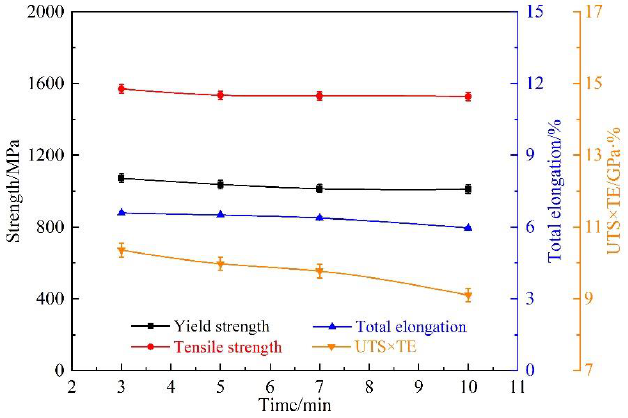
Figure 15. The strength, elongation and UTS × TE variations with different holding time.